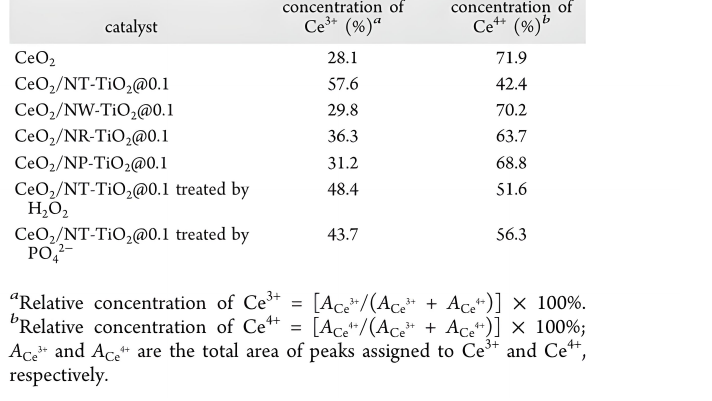
Figure 6. XPS spectra were used to calculate the concentrations of Ce 3 + and Ce 4 + , which con- firmed that the CeO 2 NT had the best peroxidase-like activity. The presence of TiO 2 promotes higher Ce 3 + concentrations in the following order: CeO 2 /NT-TiO 2 @0.1 > CeO 2 /NR-TiO 2 @0.1 > CeO 2 /NP-TiO 2 @0.1 > CeO 2 /NW-TiO 2 @0.1. In comparison to CeO 2 /NW-TiO 2 , CeO 2 /NR-TiO 2 , and CeO 2 /NP-TiO 2 . Reprinted with permission from Reference [56]. American Chemical Society 2015, all rights reserved.